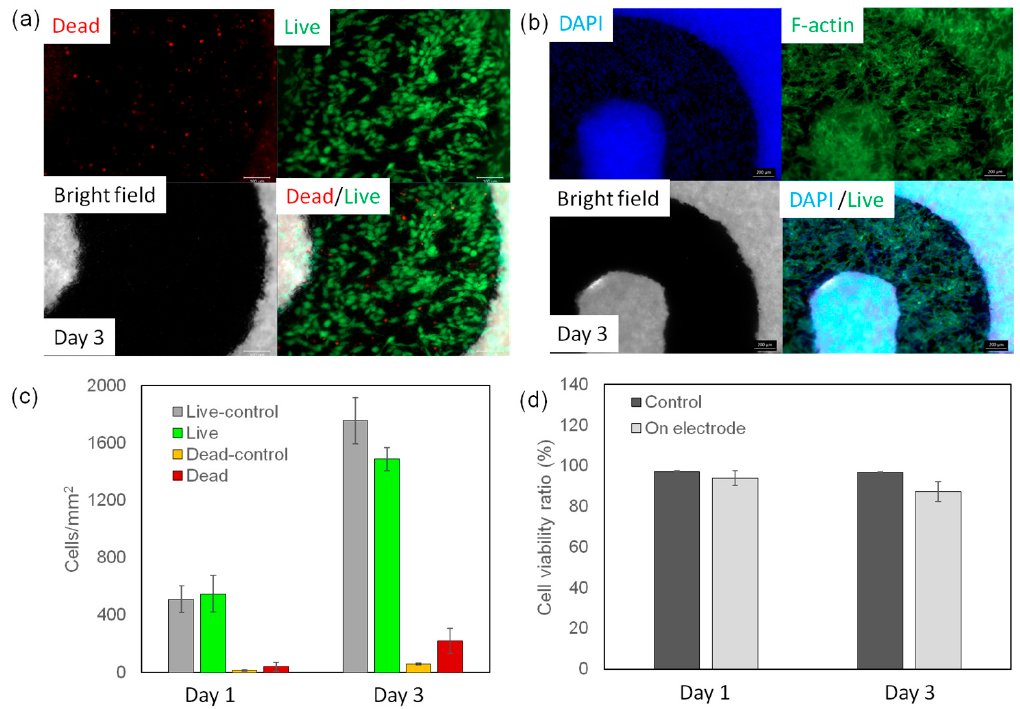
Figure 4. Biocompatibility of the PGS-PCL platform. To assess the biocompatibility of the platform, it was seeded with NIH 3T3 fibroblast cells with a concentration of 1 × 10 5 per sample. ( a ) A representative fluorescence image from a cell-seeded sample and stained using a live/dead assay kit after 3 days of culture, wherein the viable cells are marked as green and dead cells are marked as red. ( b ) Rhodamine-labeled phalloidin/DAPI staining for F-actin/cell nuclei of 3T3 cells seeded on the fabricated device, which demonstrated cellular spreading on the surface of the PGS-PCL sheet after 3 days of culture. ( c,d ) The cell density and viability ratio were analyzed and were both observed to be higher than 90%.